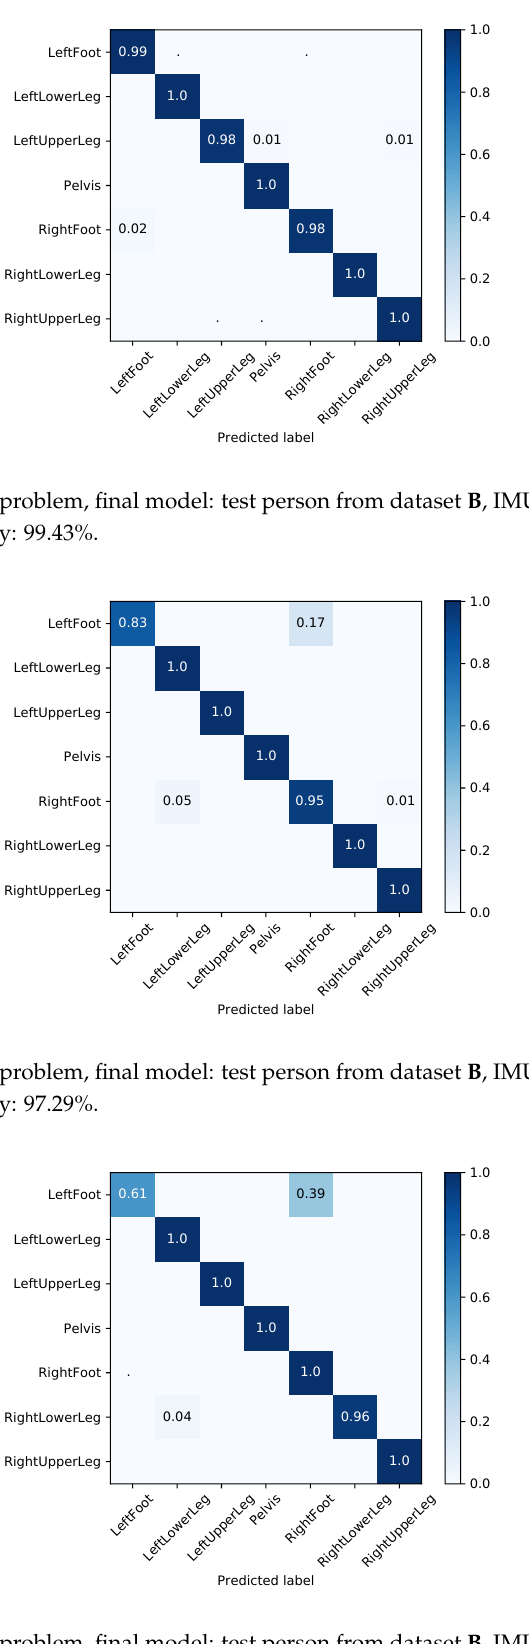
Figure A7. I2S assignment problem, final model: test person from dataset B , IMU configuration 6 (cf. Table A7). Average accuracy: